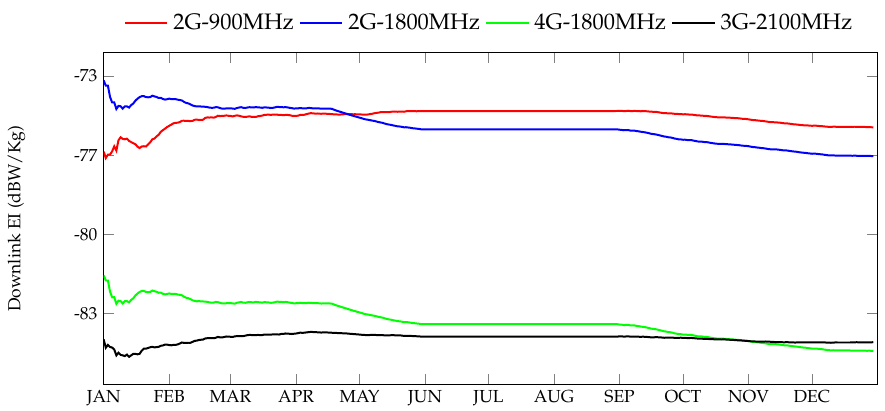
Figure 14. Temporal evolution of the downlink component of the EI in